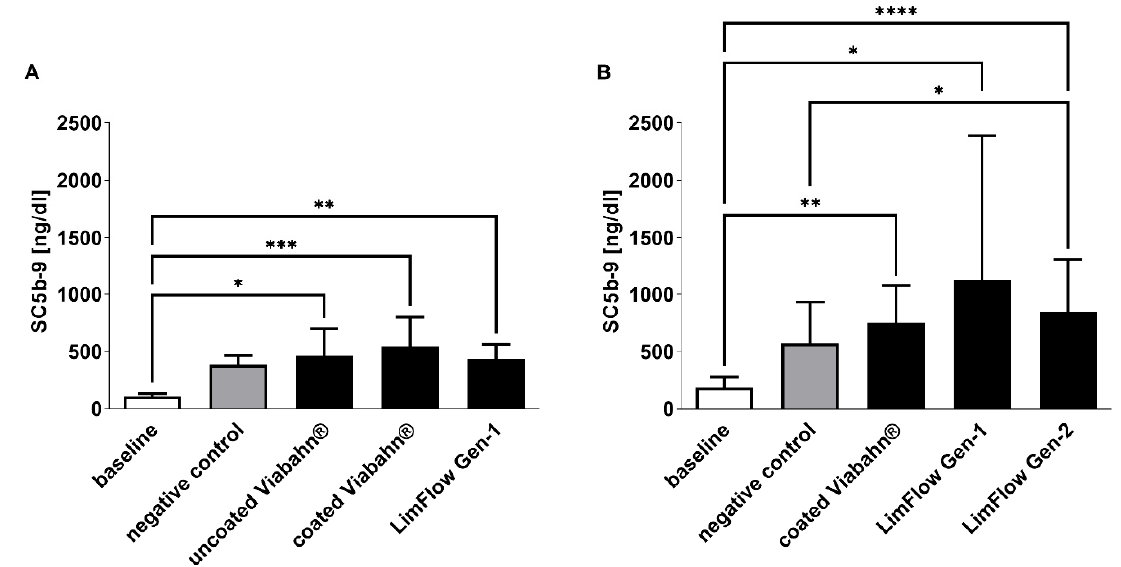
Figure 8. Analysis of complement activation by detection of SC5b-9 concentration. Detection of SC5b-9 in ( A ) experiment series B and ( B ) experiment series C. The data are shown as mean + SD. Statistical analysis was performed using the Friedman test followed by Dunn´s multiple comparison test. n = 8, (* p < 0.05, ** p < 0.01, *** p < 0.001, **** p < 0.0001).